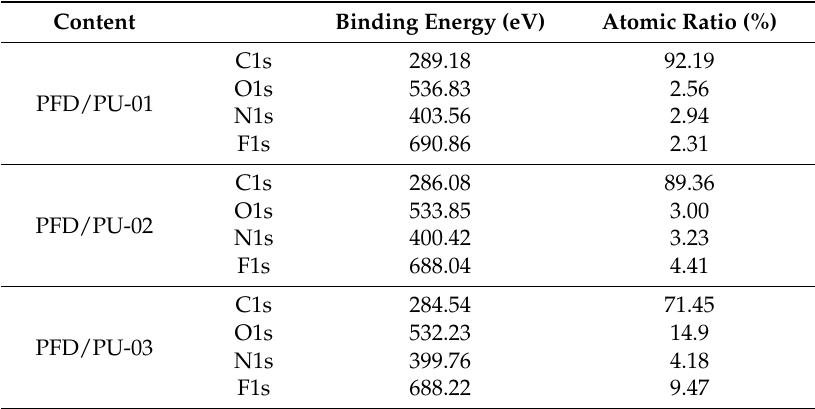
Table 3. XPS peak characteristics of PFD/PUs.